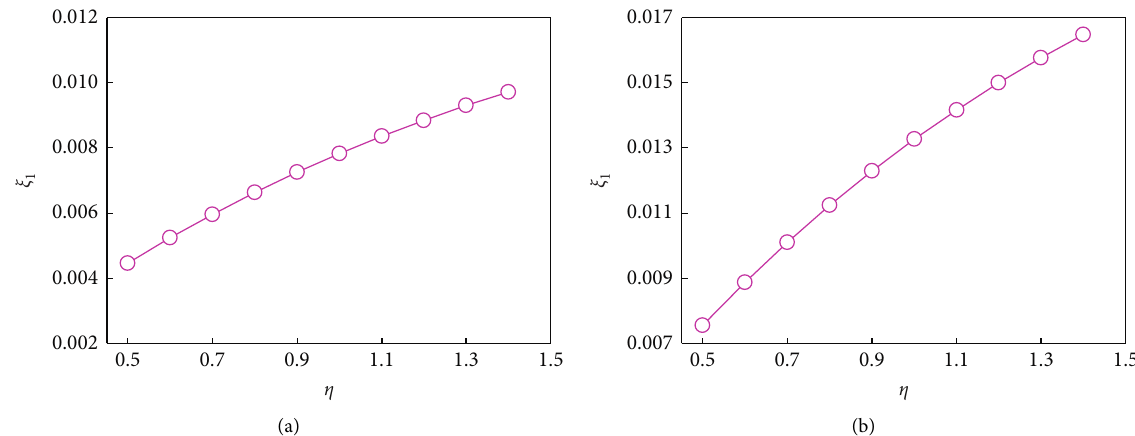
1 with η : (a) the modal strain energy method; (b) the complex modal